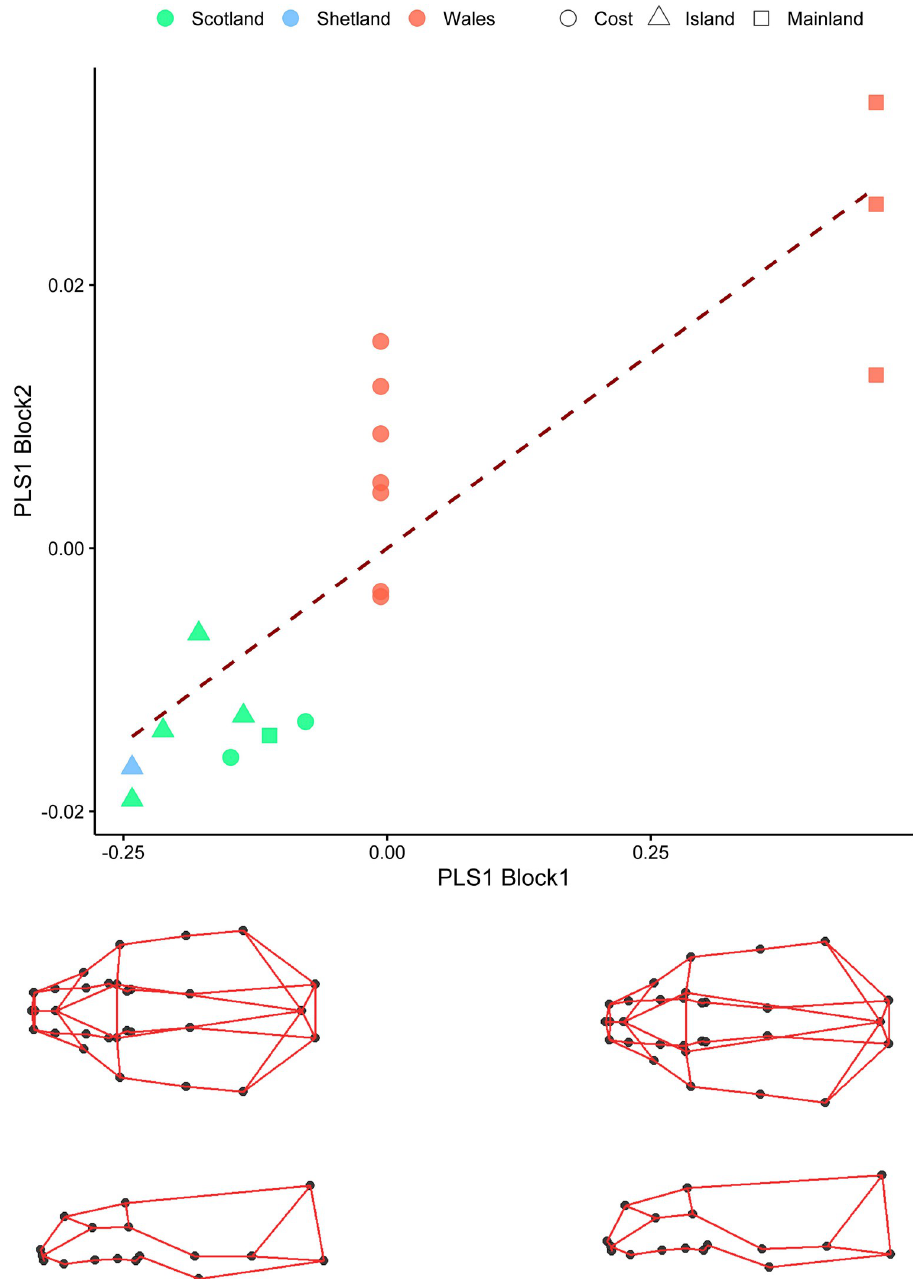
Fig 5. Relationships between mean shape and diet as shown by the PLS regression of mean skull shape on diet matrices for 18 geographically distinct sampling locations. Colours indicate the feeding areas of otters living in that locality. Below the x-axis are shown the wireframes corresponding to shape changes at the extremes of the axis. Nodes represent the landmarks, edges the anatomical connections between landmarks.